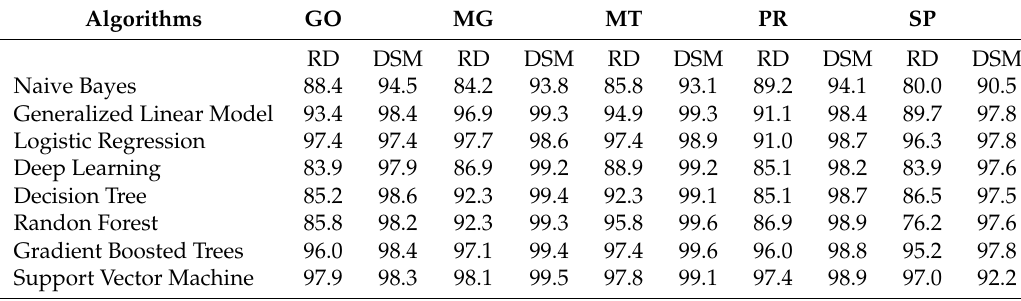
Table 3. Accuracy classification results.